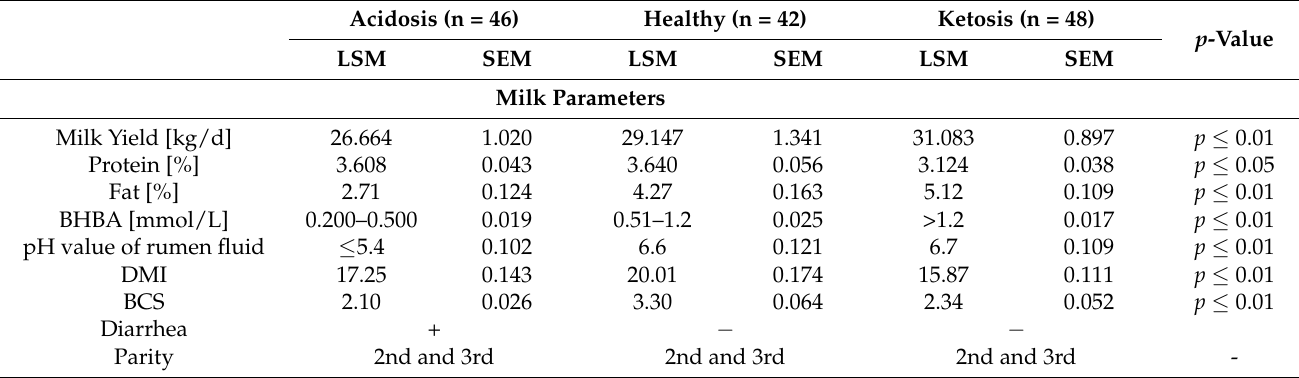
Table 1. Characteristics of the acidotic, healthy, and ketotic cows. Acidosis (n =